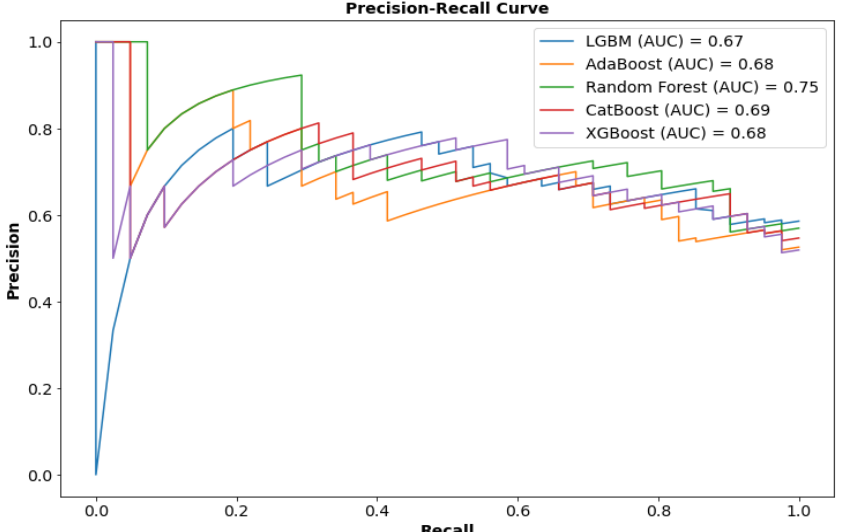
Figure 9. Combined precision – recall curve (PRC) for all Bayesian-optimized ELC models.